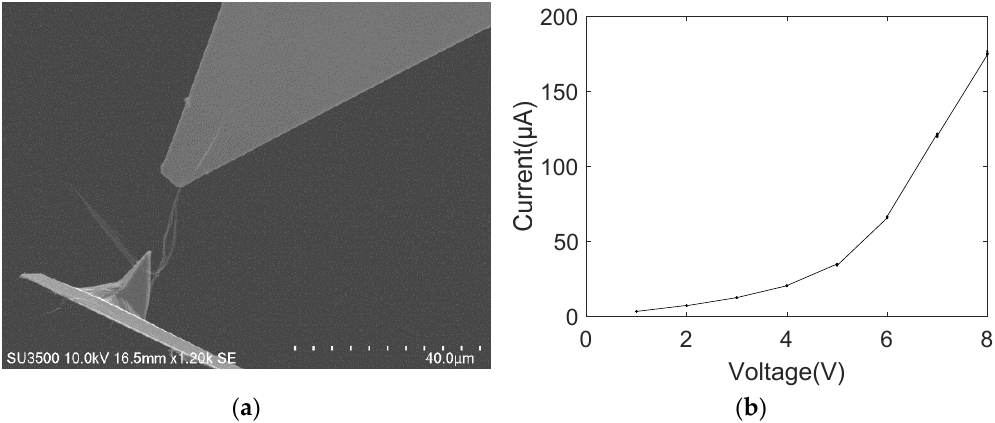
Figure 9. MWCNT bundle contacting with two gold-coated AFM probes ( a ) SEM image; ( b ) current–voltage curve.